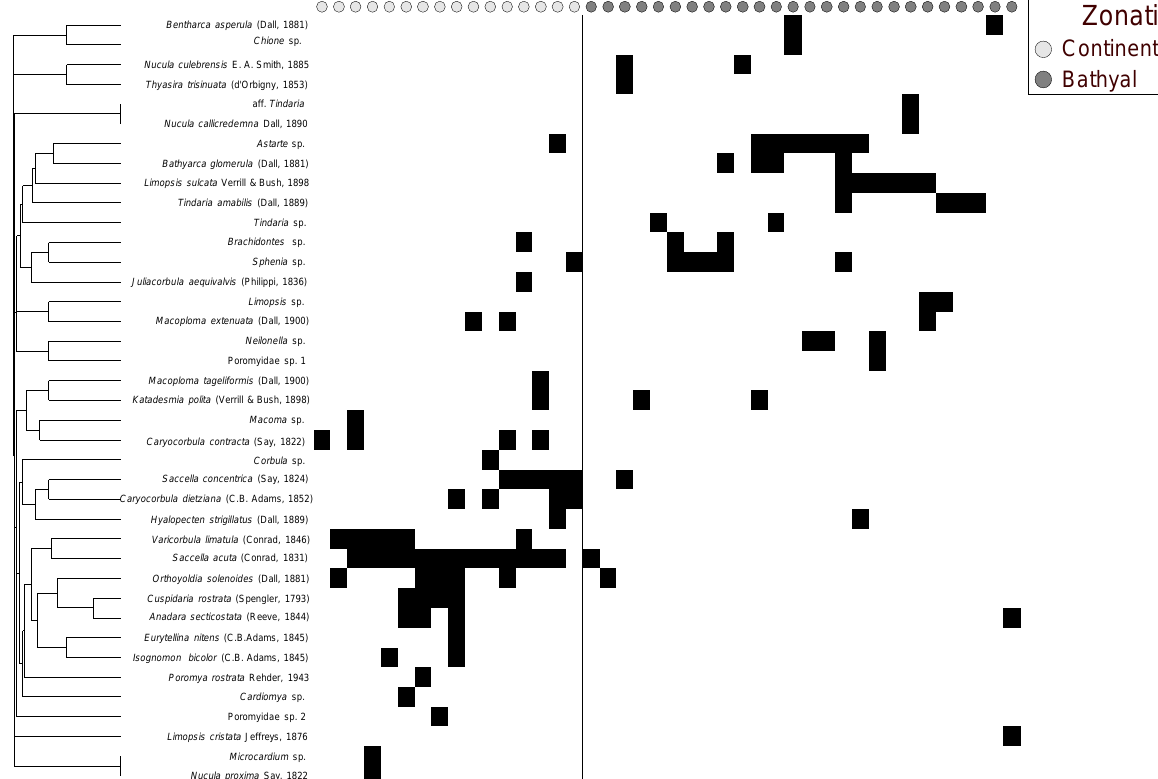
Figure 7. Shade plot for the 29 sites of the Perdido 3 cruise (June) and Perdido 4 cruise (September) 2017, dividing the data by water depth (light grey: continental shelf, 43–200 m; dark gray: bathyal, 375–3563 m), and species similarities or cluster analysis (left tree) of species was performed using the Whittaker’s Index of